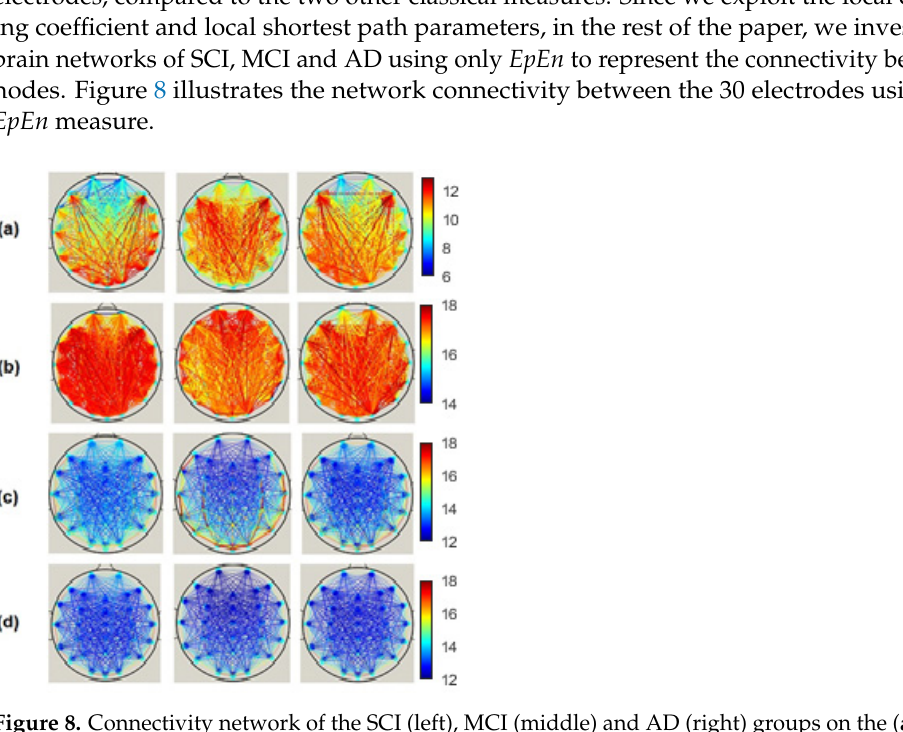
Figure 8. Connectivity network of the SCI (left), MCI (middle) and AD (right) groups on the ( a ) delta, ( b ) theta, ( c ) alpha and ( d ) beta bands.